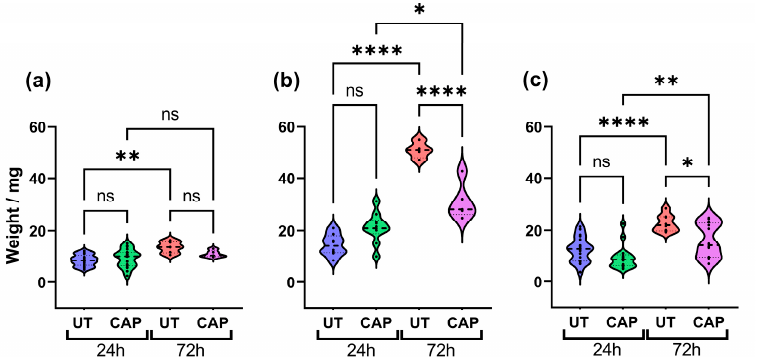
Figure 1. CAP inhibits tissue growth. Effect of CAP on tissue growth of ( a ) RLT-PSC, ( b ) Mia PaCa-2, and ( c ) RLT-PSC + Mia PaCa-2. CAP hinders the growth of co-cultured tissue, decreasing its size 72 h post treatment. n ≥ 4 tissue per condition. UT = untreated control. Each dot represents one tissue. One-way ANOVA with post-hoc Tukey’s test. Dashed lines = median; dotted lines = 25% and 75% quartiles; * = p ≤ 0.05; ** = p ≤ 0.01; **** = p ≤ 0.0001; ns = not significant.